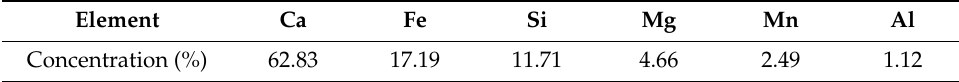
Table 4. Mass concentration of main elements in steel slag.